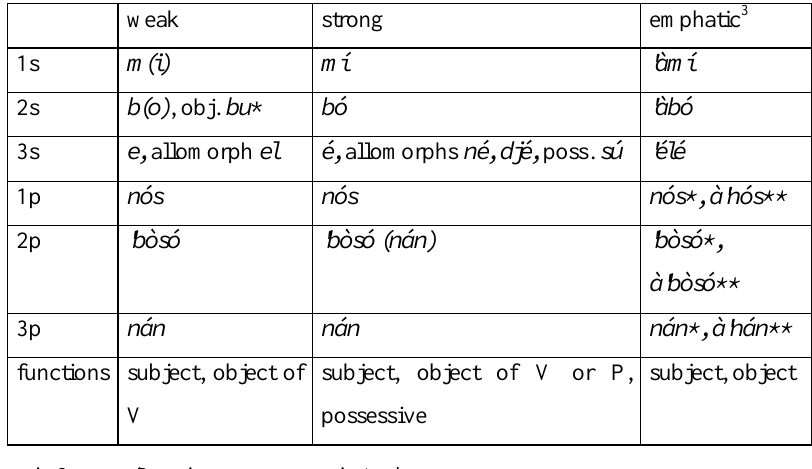
Table 2. Papiamentu pronouns, according to the present